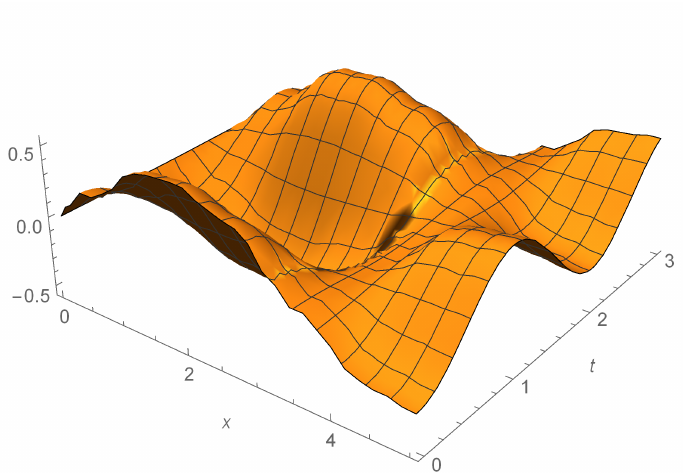
Figure 2. Longitudinal fractional wave on Cantor longitudinal coordinates ( α = 0.7 )